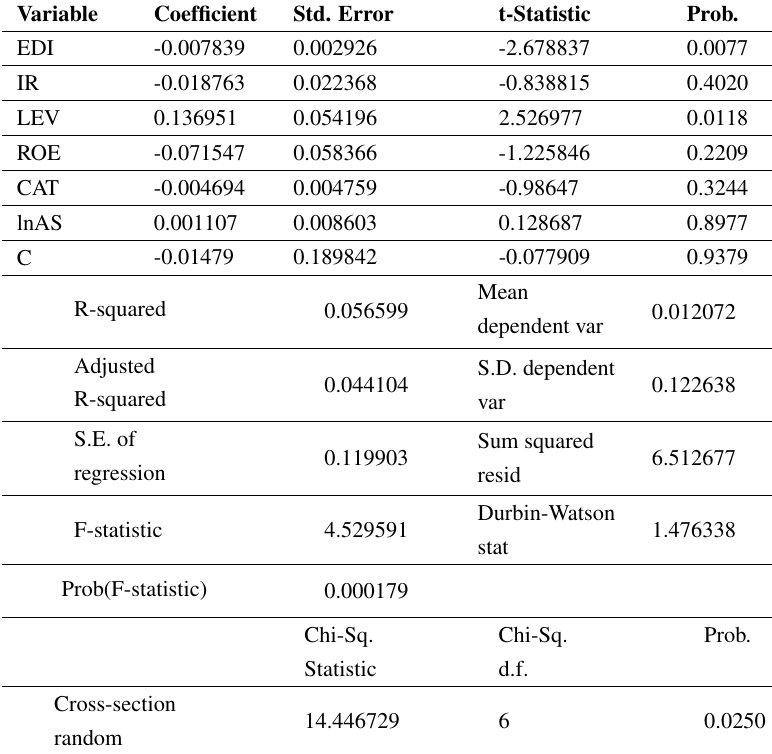
Table 5 The Hausman test of second